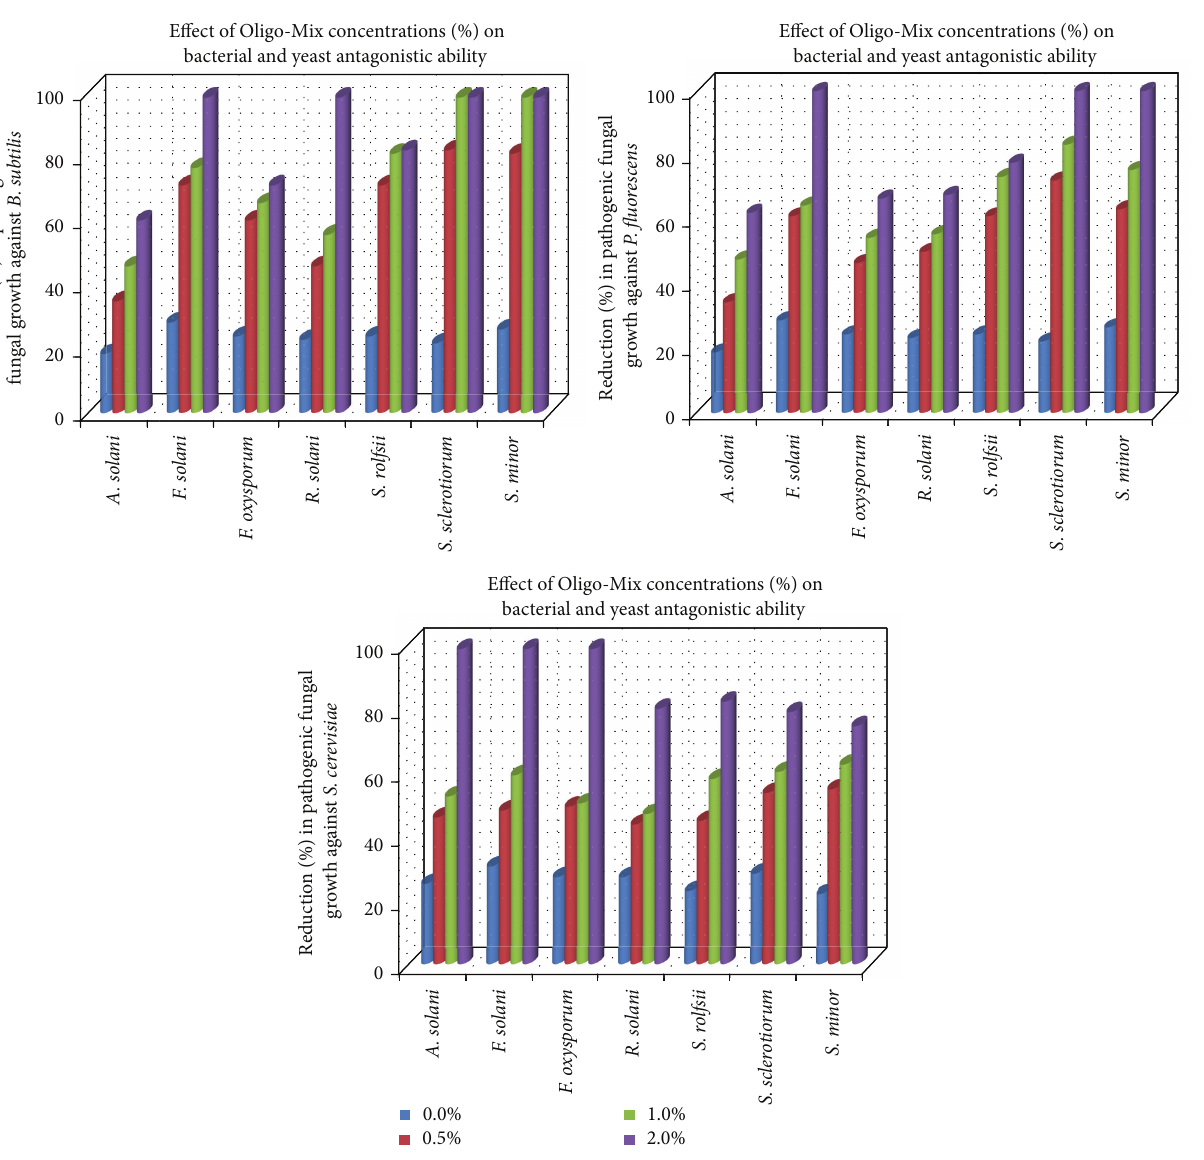
Figure 4: Reduction (%) in pathogenic fungal growth against bacteria and yeast in medium supplemented with Oligo-Mix at different concentrations in vitro